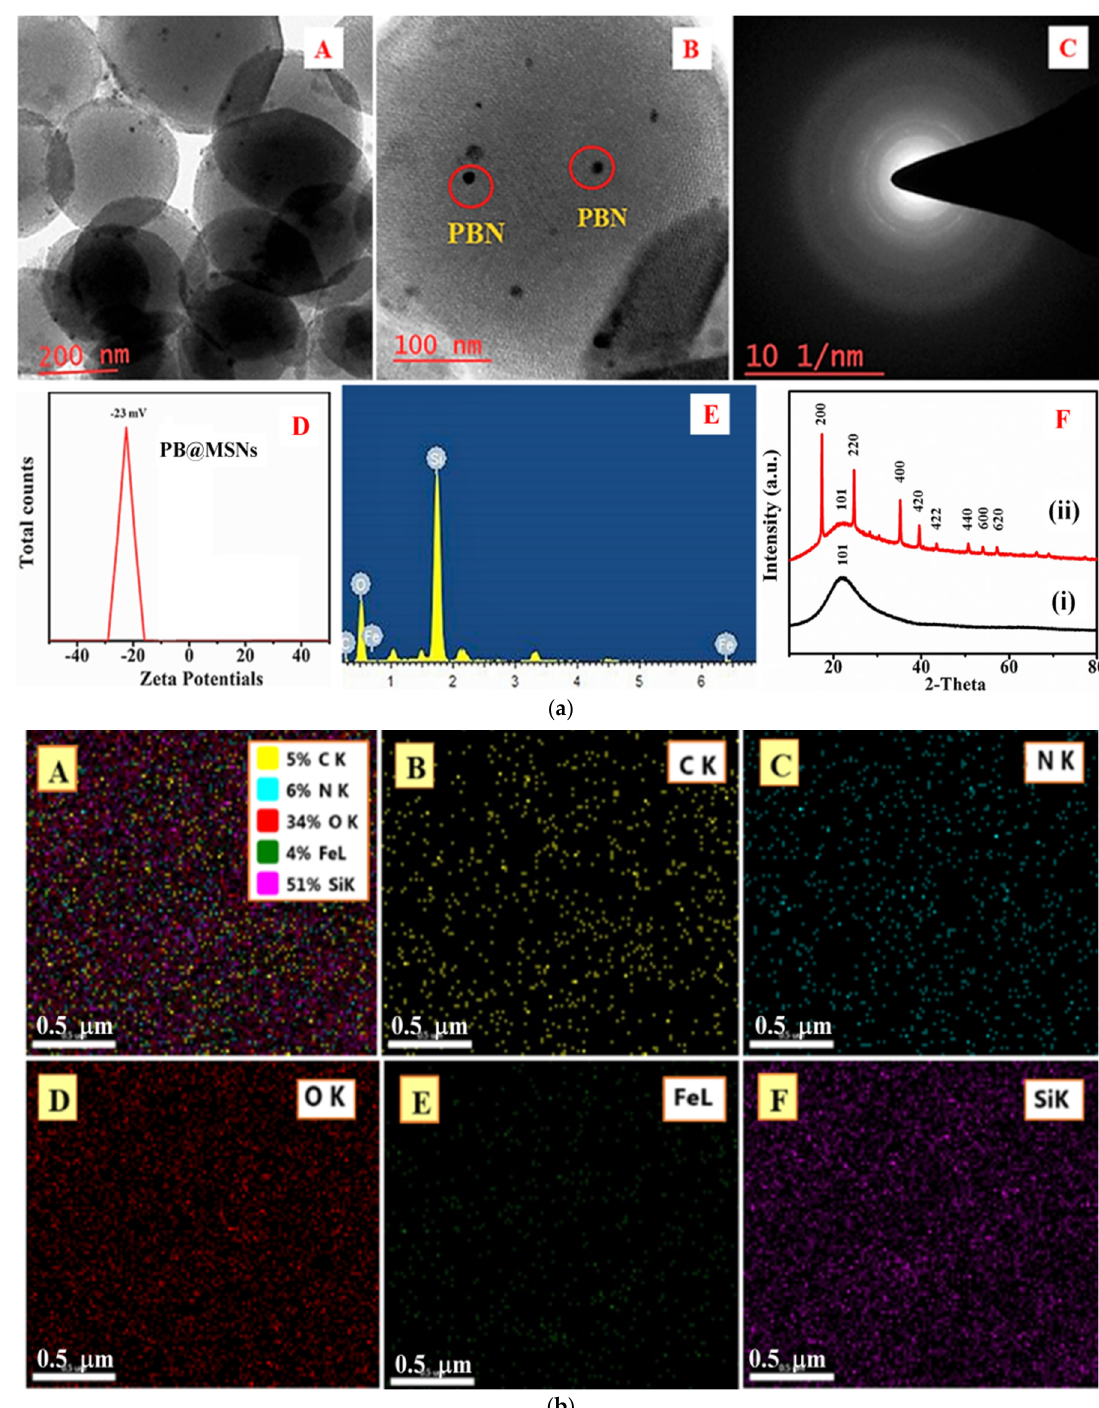
Figure 3. ( a ) ( A ) HRTEM image of organotrialkoxysilane-functionalized Prussian blue nanoparticles (PBN@MSN), ( B ) mi- crograph showing the magnified view of bulk-confined PBN (encircled in red) in mesoporous silica, ( C ) SAED pattern of the corresponding hybrid nanoparticle assembly (PBN@MSN), ( D ) stability profile of PBN@MSN in terms of zeta potential measurement, and ( E ) EDX spectrum of PBN@MSNP. ( F ) XRD profile for MSNPs (i) and as-synthesized PBN@MSNPs (ii). ( b ) ( A ) Mapping analysis of organotrialkoxysilane-functionalized Prussian blue nanoparticles with elemental composition ( B ) carbon, ( C ) nitrogen, ( D ) oxygen ( E ) iron, and ( F ) silicon. The EDX spectrum of PBN@MSNPs is shown in Figure 3a (E). The EDX mapping of the organotrialkoxysilane-functionalized PBN@MSNPs with the elemental composition of